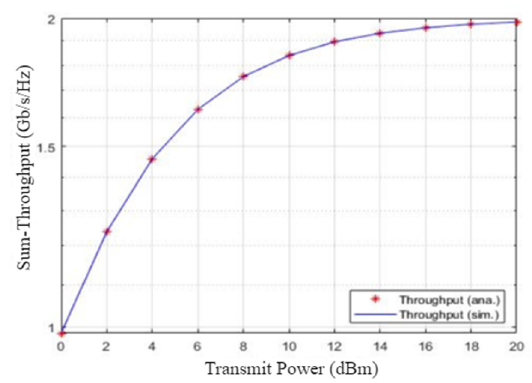
Figure 4. Throughput vs. transmit power.